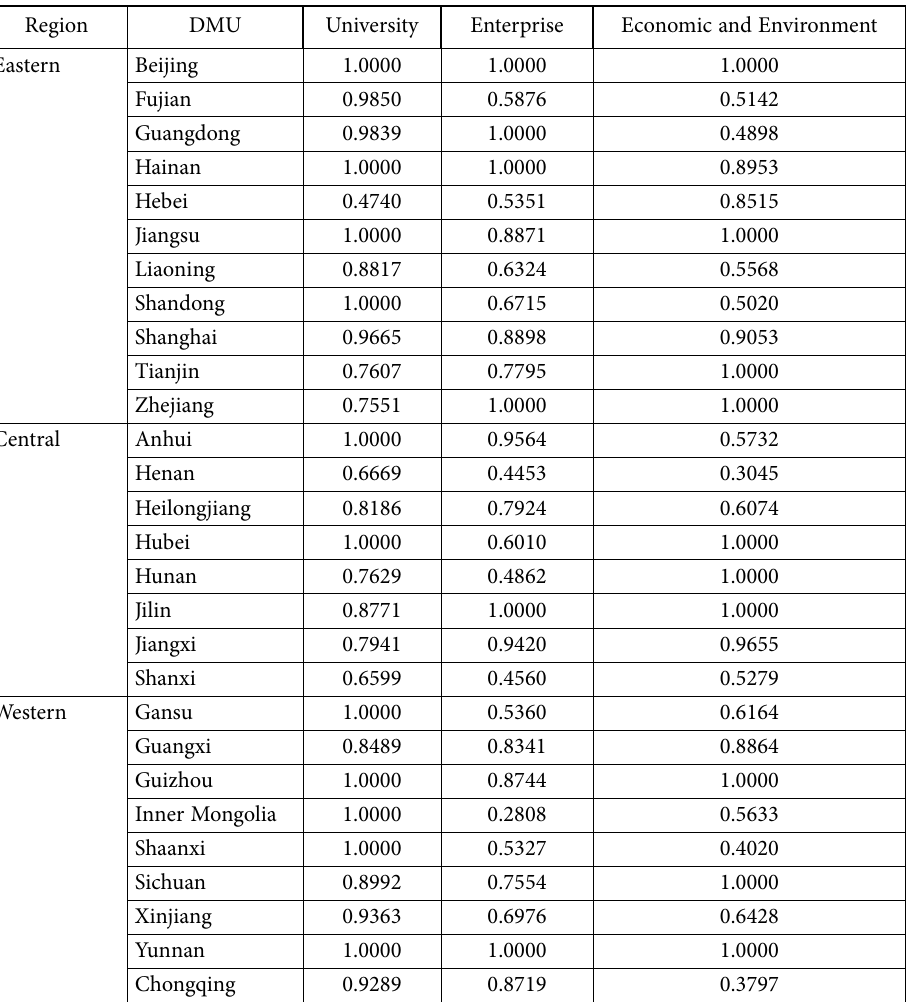
Table 5. Efficiency from 2015 to 2019 of the university innovation stage, enterprise innovation stage, and economic and environment stage Region